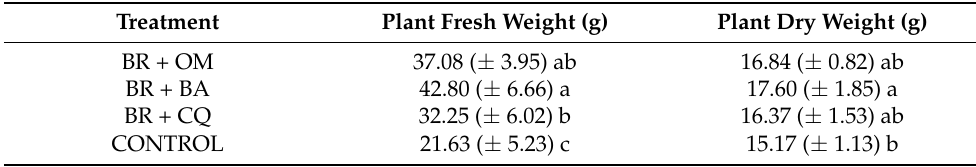
Figure 6. Effect of treatments on the % of emerged seedlings. Different letters mean statistically significant differences (value p ≤ 0.05) in LSD test. Table 10. Effect of treatments on the fresh and dry weight of the emerged seedling.